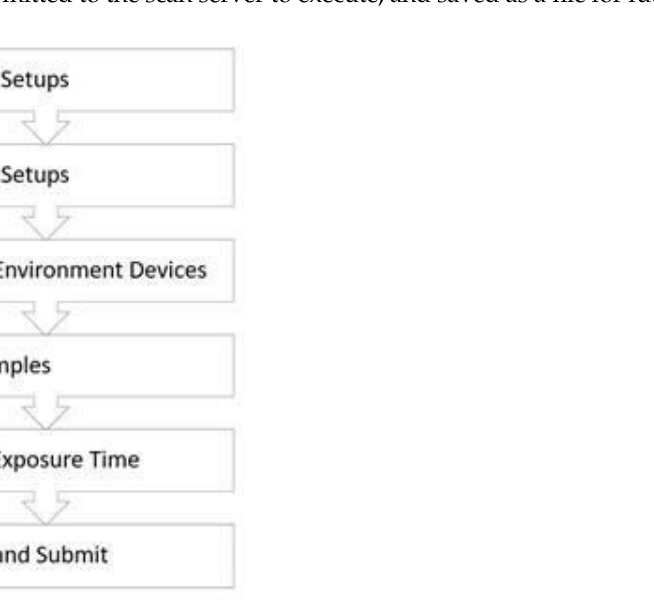
Figure 7. The workflow laid out by different tabs in the Panel Scans interface (details on the workflow tabs are presented in the Supplemental Materials).